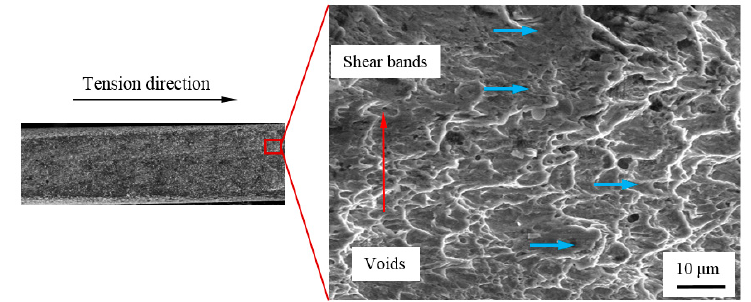
Figure 7. Fracture morphology of S-0.